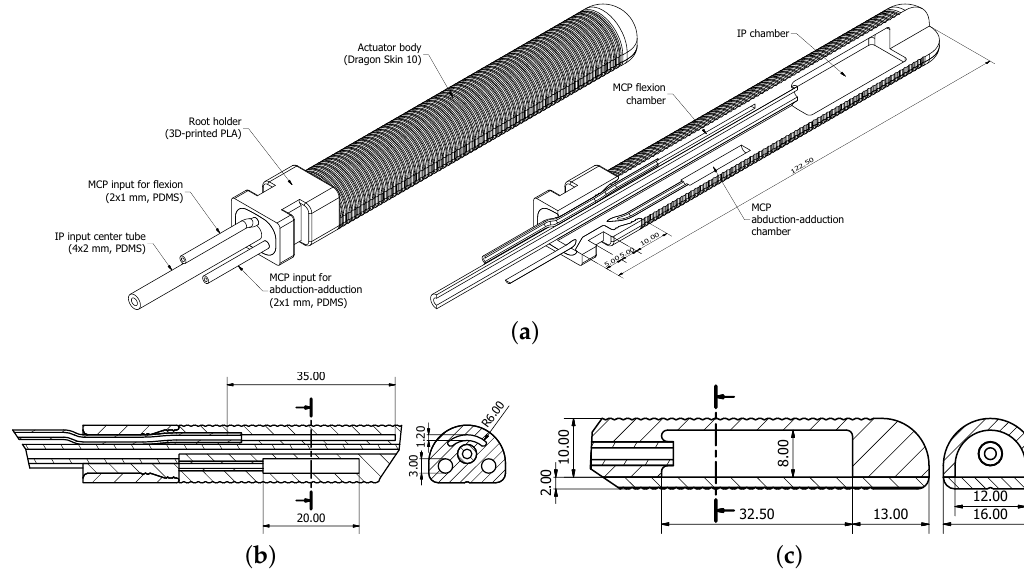
Figure 1. CAD drawings of the designed actuator’s ( a ) overall structure and details of the ( b ) proximal MCP chambers and ( c ) distal IP